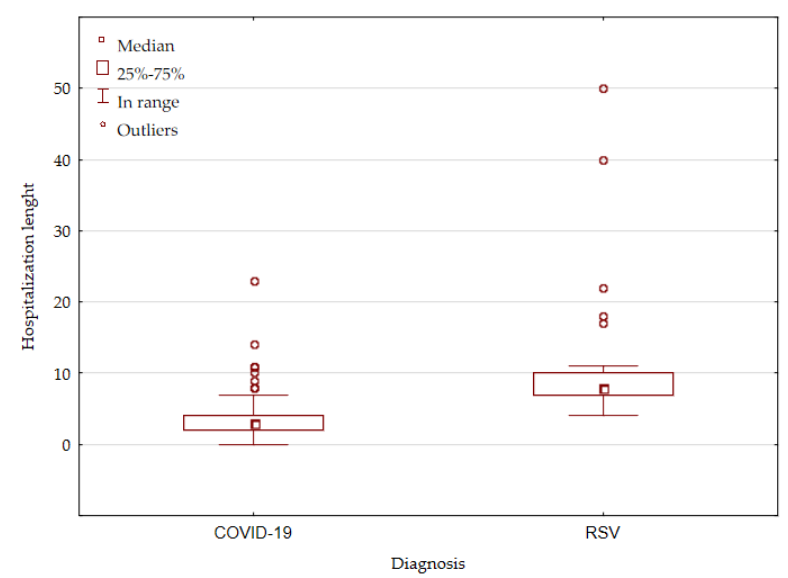
Figure 2. Hospitalization length comparison between the groups.